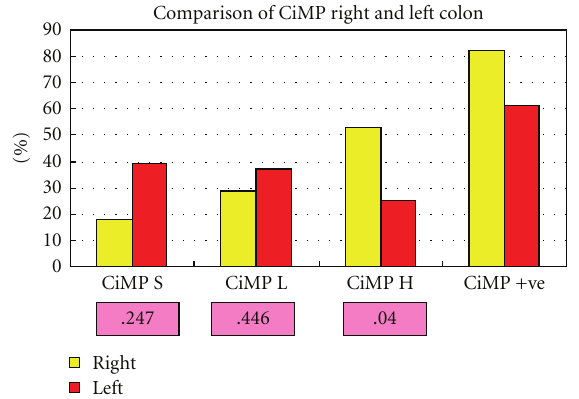
Figure 5: CiMP for left- and right-sided HPs, P values (Chi 2 ) pink boxes.